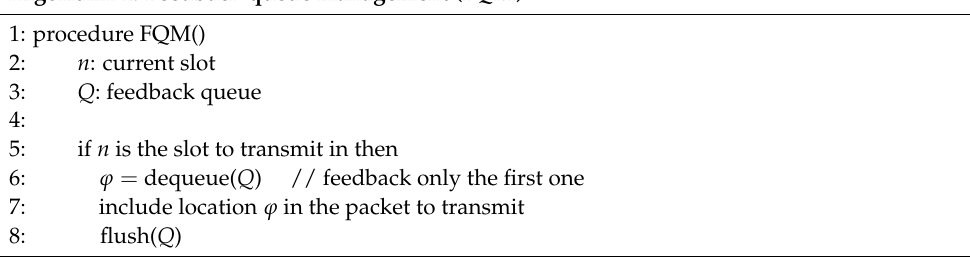
Algorithm 2 Feedback queue management (FQM) Algorithm 2. Feedback queue management (FQM)